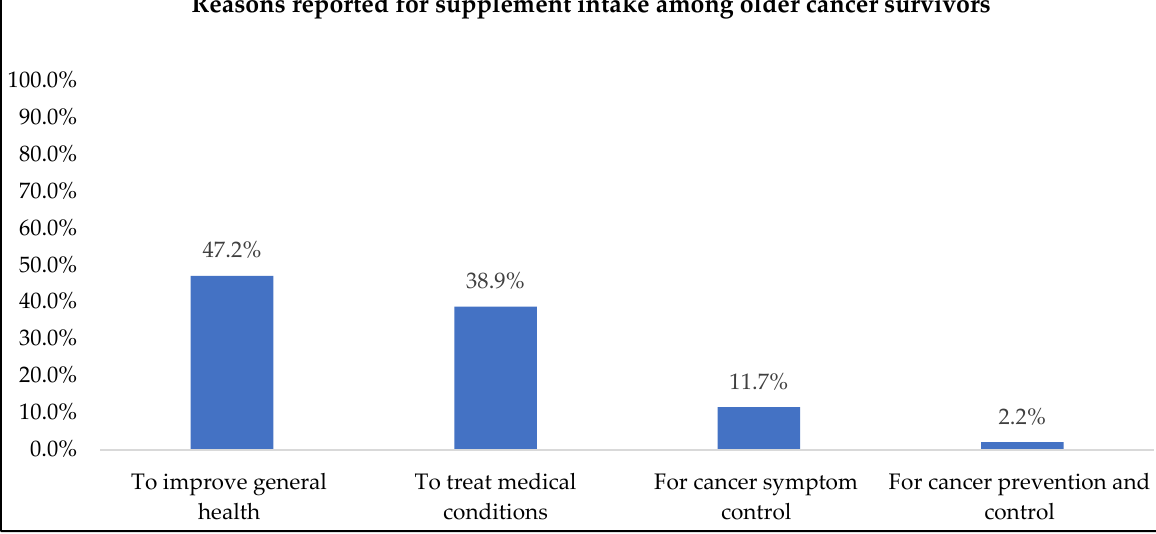
Figure 2. Primary reasons reported for dietary supplement use among older cancer survivor supplement users ( n = 215).